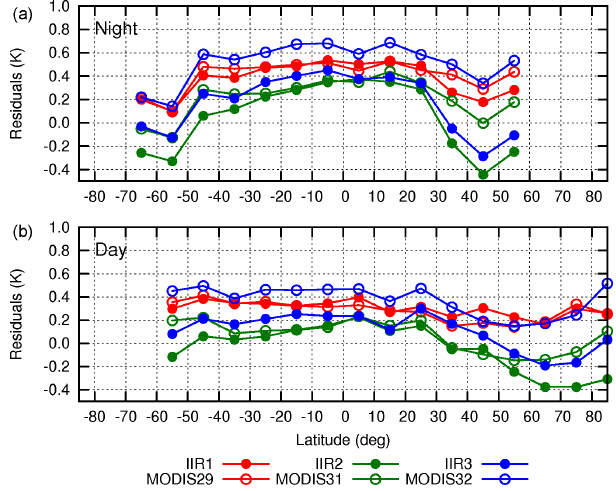
Figure 14. Residuals against latitude in July 2007 for the three pairs of IIR and MODIS channels (IIR1 and MODIS29: red, IIR2 and MODIS31: green, IIR3 and MODIS32: blue, IIR: full circles, MODIS: open circles). (a) Night. (b)